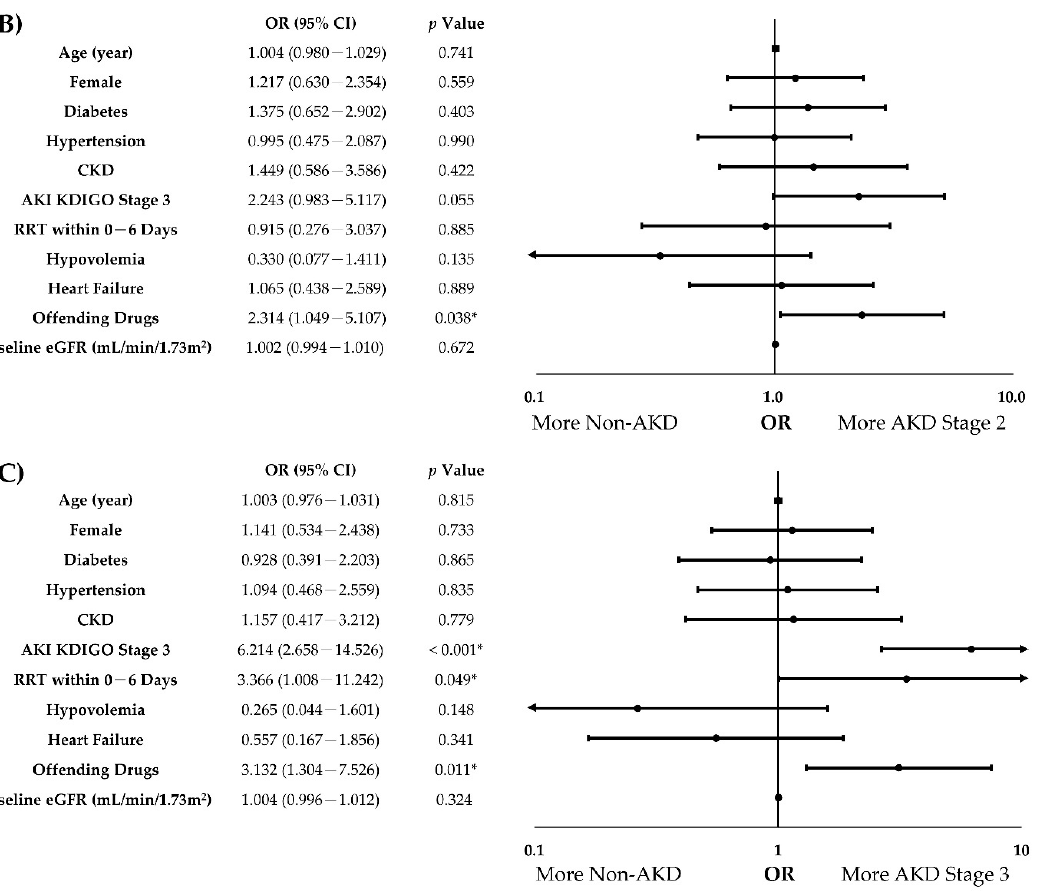
Figure 2. Forest plots of independent predictors of AKD severity in patients with AKI. ( A ). AKD Stage 1 vs. non-AKD; ( B ). AKD Stage 2 vs. non-AKD; ( C ). AKD Stage 3 vs. non-AKD. Age, sex, diabetes, hypertension, and covariates with a p -value of < 0.10 in univariate analyses were adjusted for multinomial logistic regression analysis with the enter method. CI, confidence interval; CKD, chronic kidney disease; eGFR, estimated glomerular filtration rate; OR, odds ratio. *: p < 0.05.